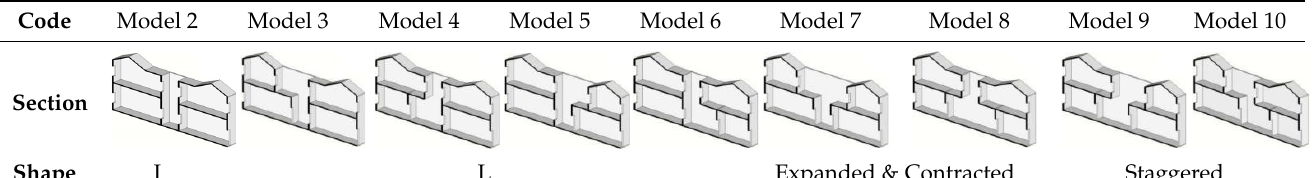
Table 5. Different sectional shapes of the courtyard.